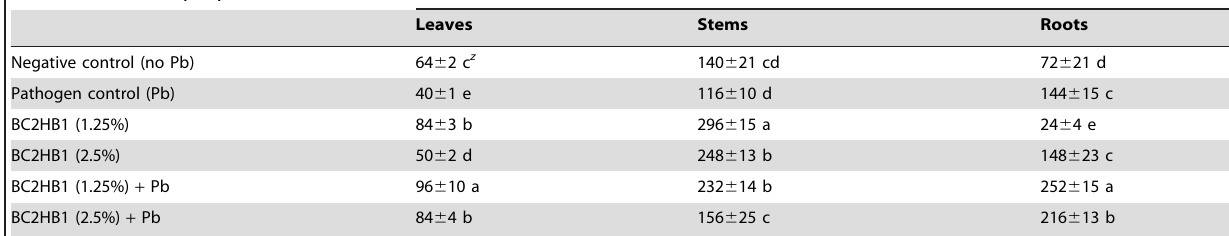
Table 3. Mean phenylalanine ammonia lyase (PAL) activity in fresh leaves, stems and roots of canola plants treated with Heteroconium chaetospira strain BC2HB1 at 1.25 or 2.5% (w/v) with or without inoculation with Plasmodiophora brassicae (Pb) (n=6)